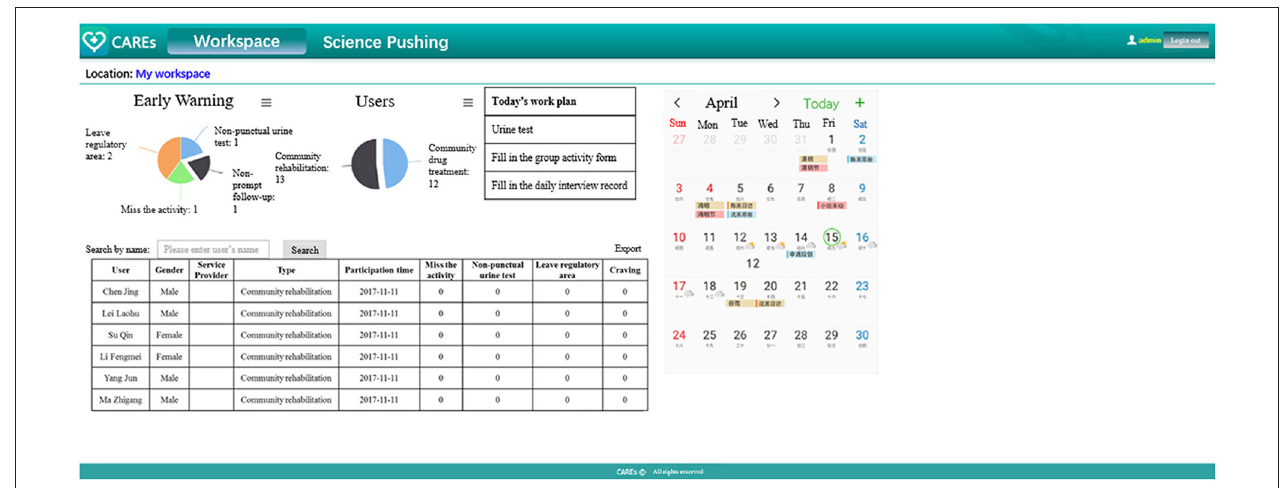
FIGURE 3 | The main “screen” of the service provider web portal. For better understanding, we translated some Chinese on the page into English. The webpage is actually presented in Chinese.